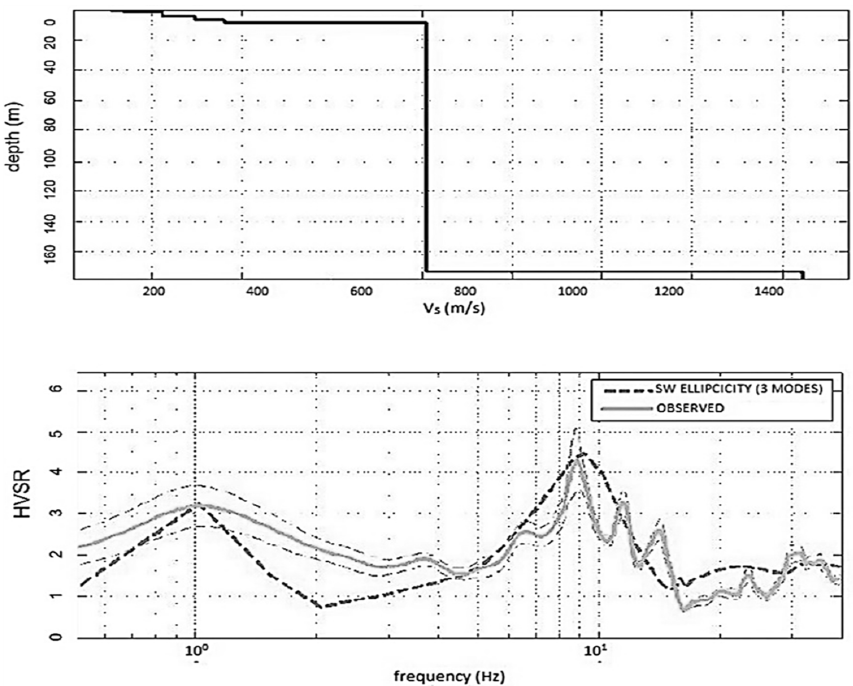
Figure 3. Illustration of the geotechnical stratigraphic profile near the Vizzana-Zampogna viaduct highlighted in [42].